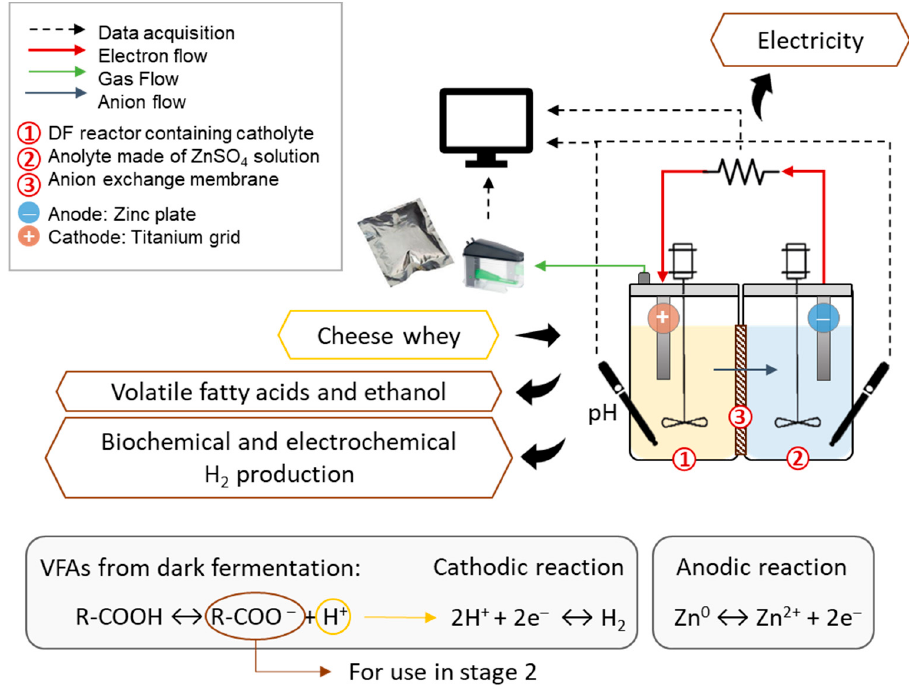
Figure 2. Experimental setup of the IBH 2 S (stage 1).